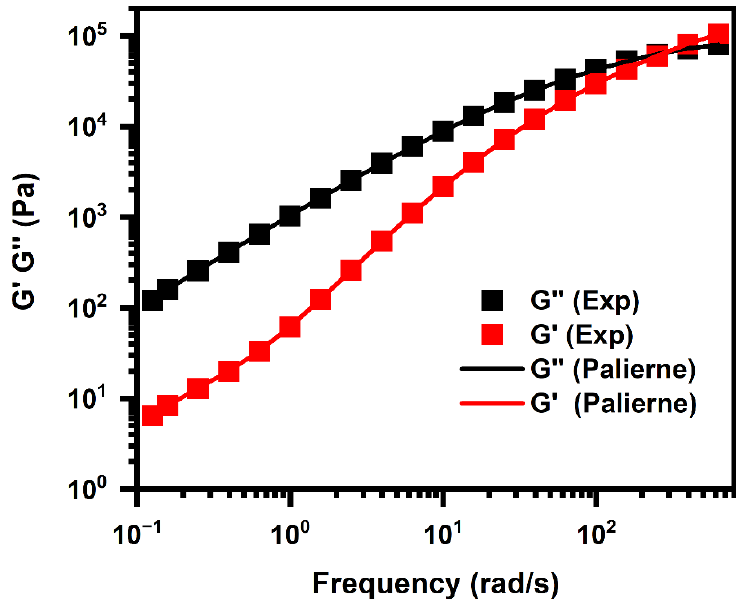
Figure 14. Experimental G (cid:48) and G (cid:48)(cid:48) with the fitted simple Palierne model (solid lines) for PLA/PHBV = 20/80 at 175 °C.